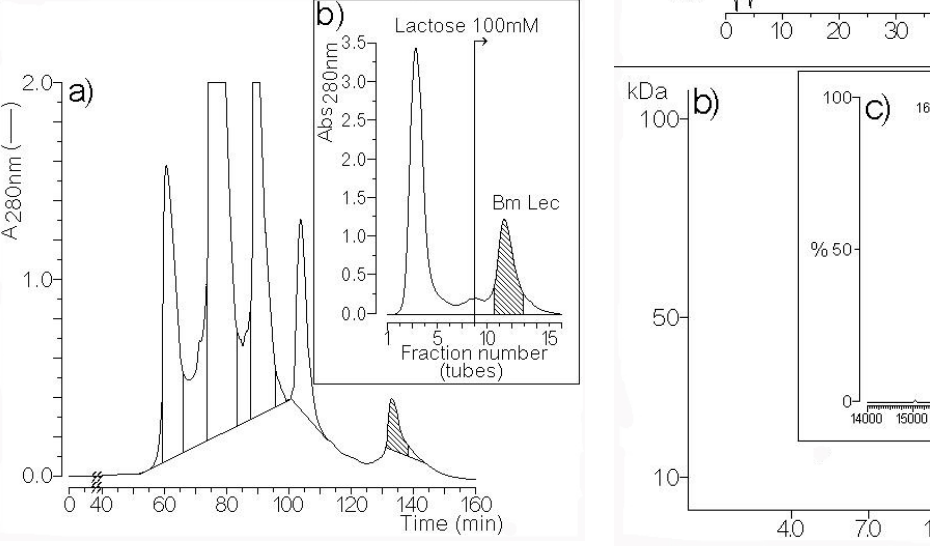
Figure 2. ( a ) Approximately 1 mg of the BmLec obtained from the affinity chromatography was dissolved in buffer A, and this solution was centrifuged at 4500 x g for one minute. The resulting supernatant was applied to the reverse phase HPLC of the purified lectin from Bothrops moojeni venom that appears as the main fraction, which was eluted using a linear discontinuous gradient of acetonitrile 66% in buffer A (buffer B). The entire chromatographic system was equilibrated with buffer A (TFA 0.1%). ( b , c ) Analysis by two-dimensional electrophoresis showed the presence of an acid protein of approximately 16 kDa; mass spectrometry showed a molecular mass of 16307.36